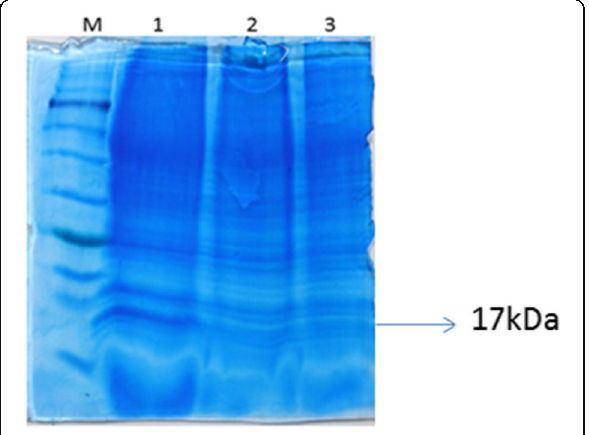
Fig. 1 Protein samples of Chilo partellus moth on SDS-PAGE. M protein marker; 1, 2, 3 pheromone-binding